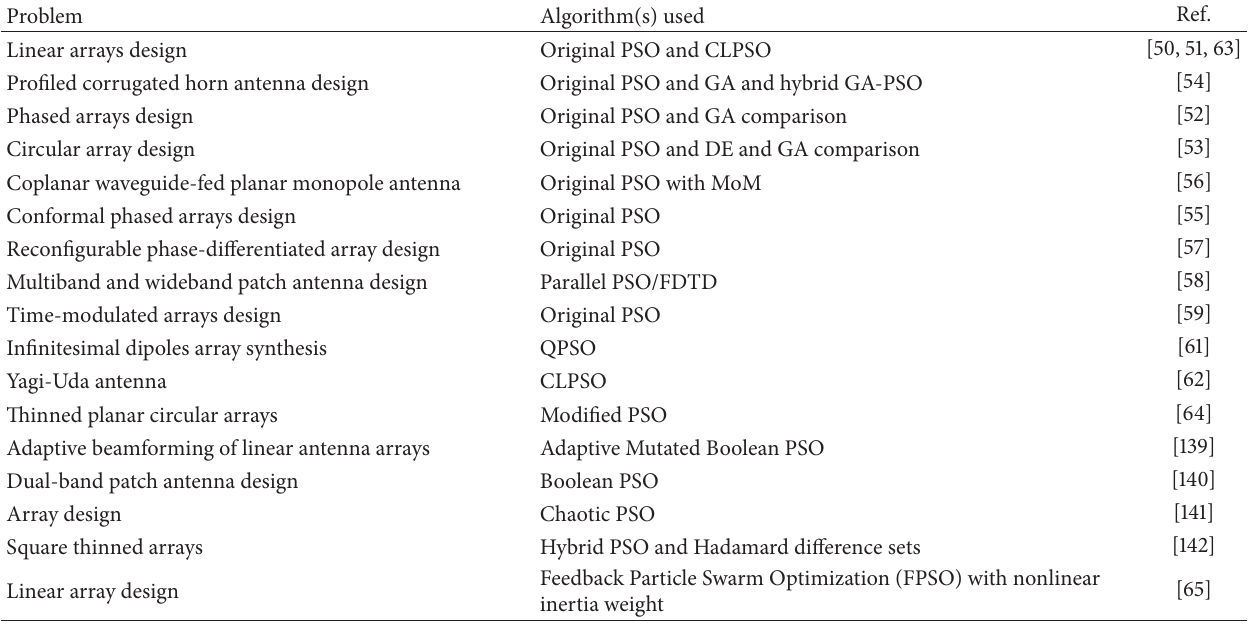
Table 2: Selected journal papers that use PSO for antenna design.